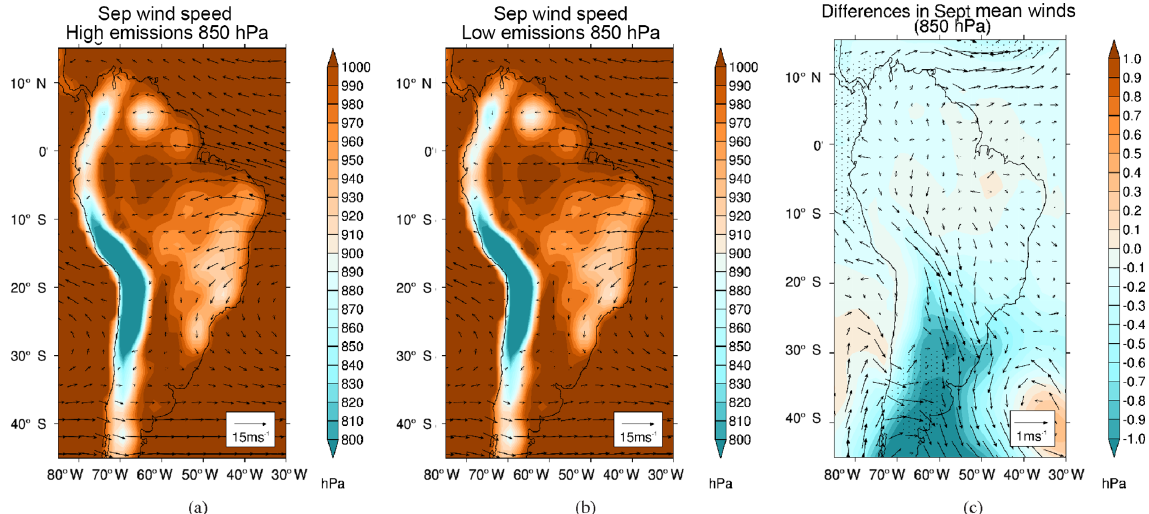
Figure 16. September mean wind circulation at 850hPa for (a) high emissions case (coloured contours are mean September pressure in hPa), (b) low emissions case, and (c) differences in pressure and wind circulation for high − low runs. Coloured contours in (a) and (b) are surface pressure and in (c) surface pressure differences in